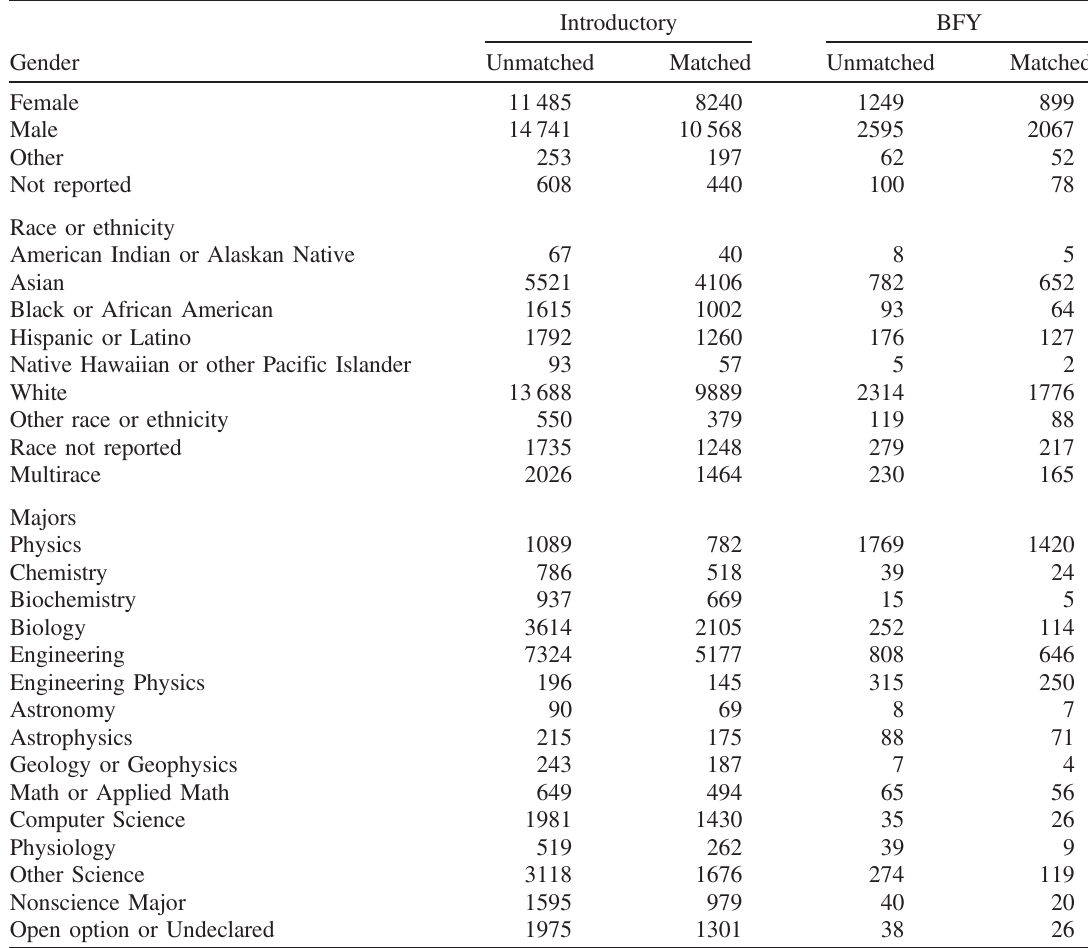
TABLE II. Demographic responses for the ECLASS dataset. Data are reported as matched or unmatched because demographics questions are asked on the postsurvey only. In each case, demographic numbers are reported for unique student responses. “ Unique ” is defined as the first time a student responds to a survey at a particular level. If the same student has taken both introductory courses and BFY courses they will show up, at most, twice. Once in each category. (Note this is just for demographic counts, all student data still exist for all courses in the dataset.) We include both “ matched ” and “ unmatched ” categories. Matched is defined as the student has replied to both pre- and postsurveys. Unmatched means the student has replied to only the postsurvey because the demographic questions are asked in the postsurvey. Additionally, the student ’ s declared major is included in the ECLASS dataset.